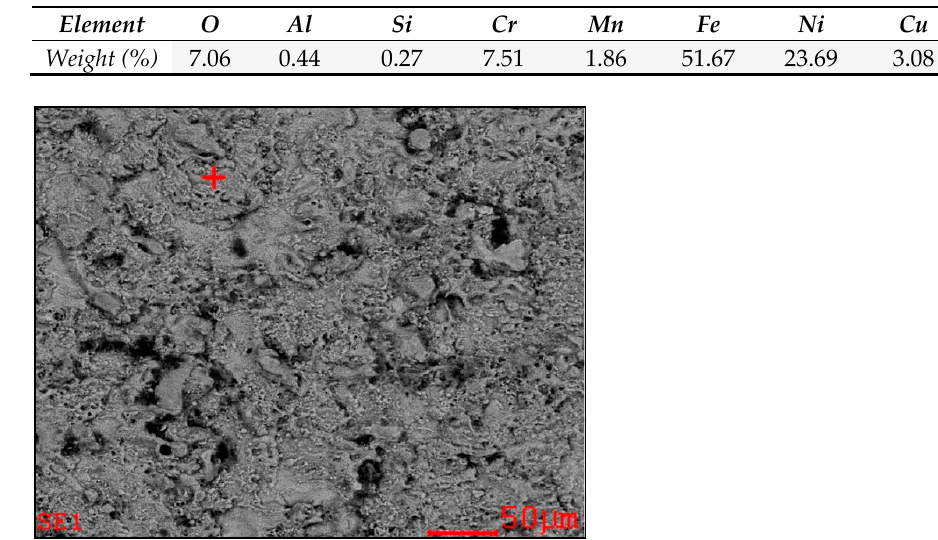
Figure 7. Superficial image of OC4 alloy after 500 h in LiOH at 470 °C.